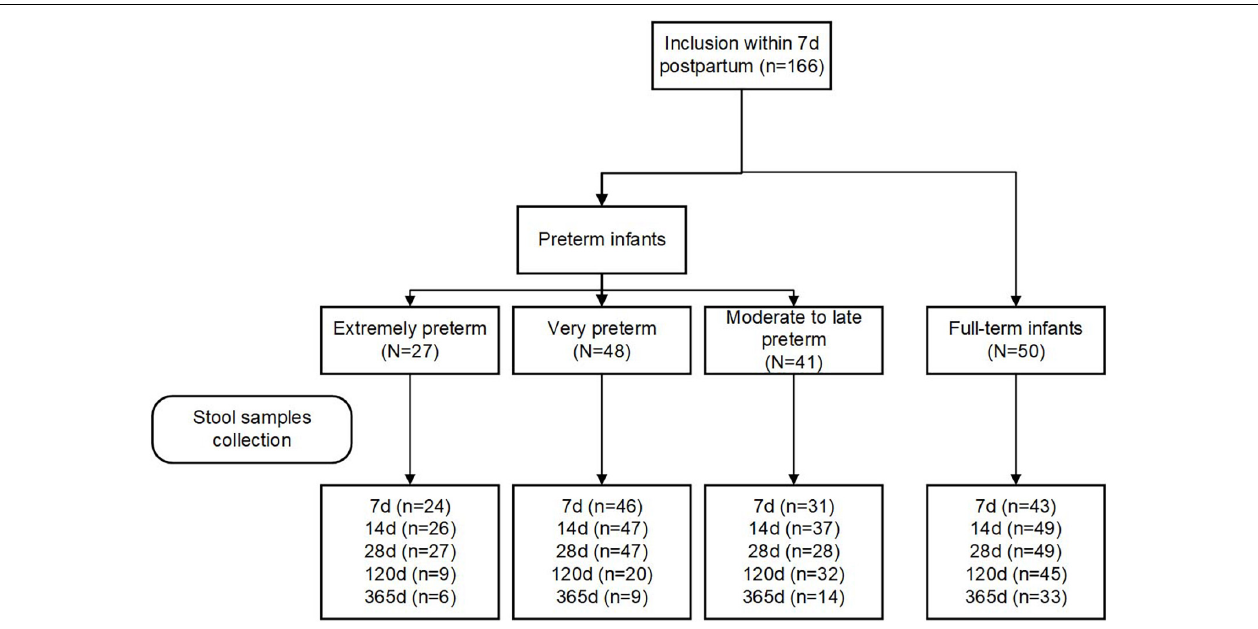
FIGURE 1 | Flow chart of the study